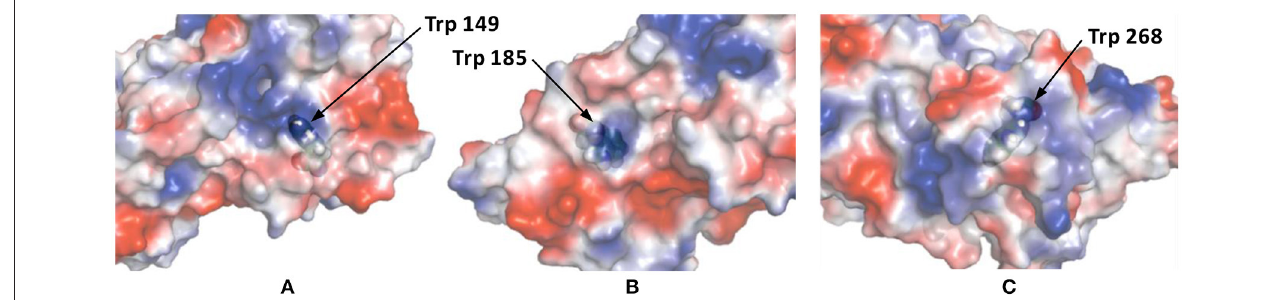
FIGURE 6 | The surface charge of OVA as rendered by PyMol’s Vacuum Electrostatics. Red, white and blue stand for negative, neutral and positive surface charges, respectively. (A) displays Trp residue 149 and is solvent accessible through a positive surface patch. (B) shows Trp residue 185, which is not solvent accessible, but is still in close proximity of a positive patch. The final Trp residue, 268, is shown in (C) . This solvent accessible Trp residue is located in a small, positive surface patch.